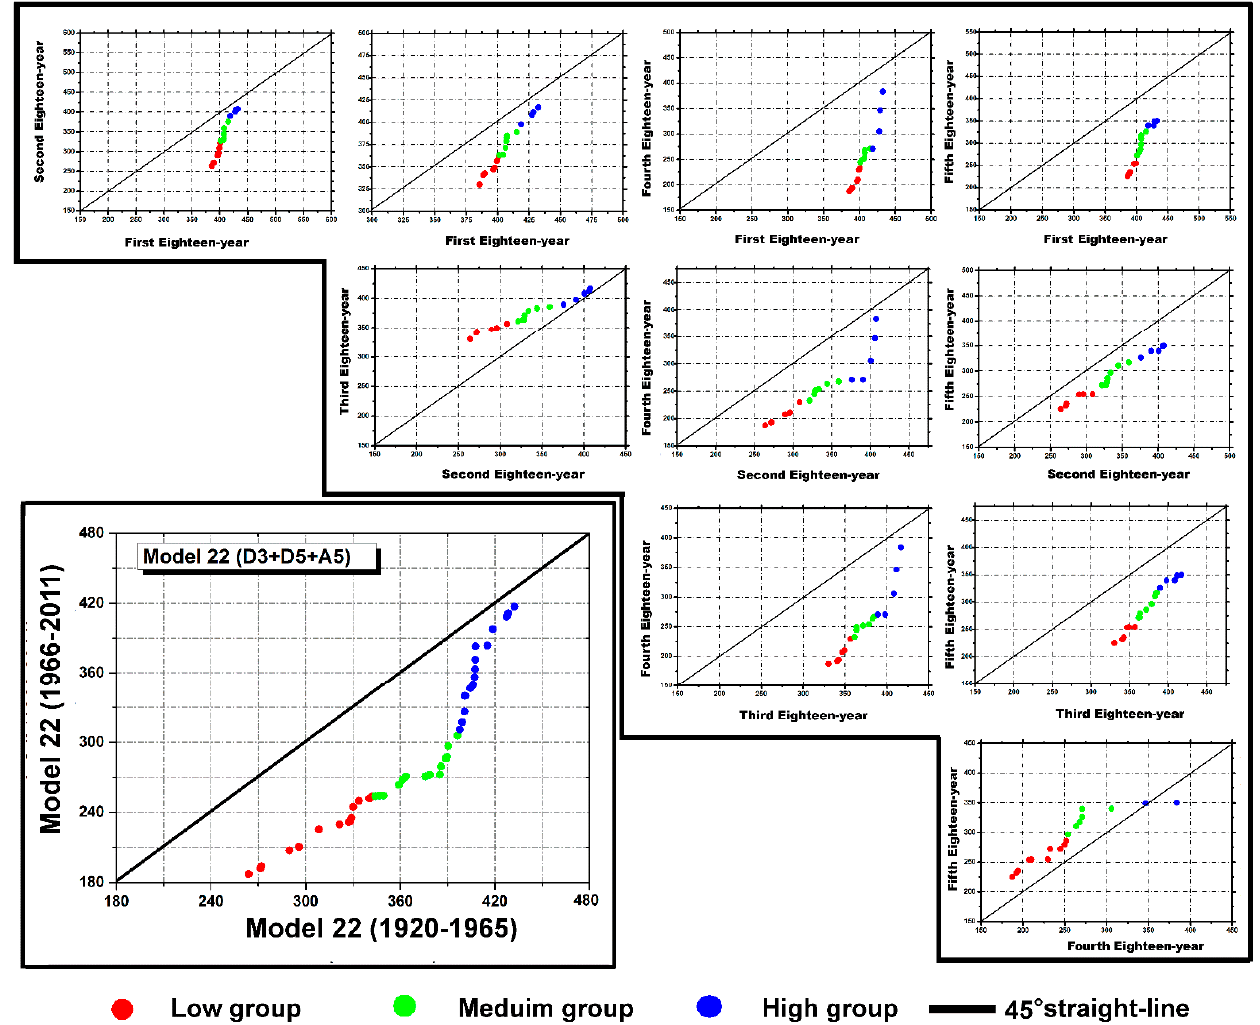
Figure 7. Triangular trend analysis methodology applied on rainfall Model (M22) resulting from DWT (ITTM − DWT: hybrid method) of Oued Taria station.